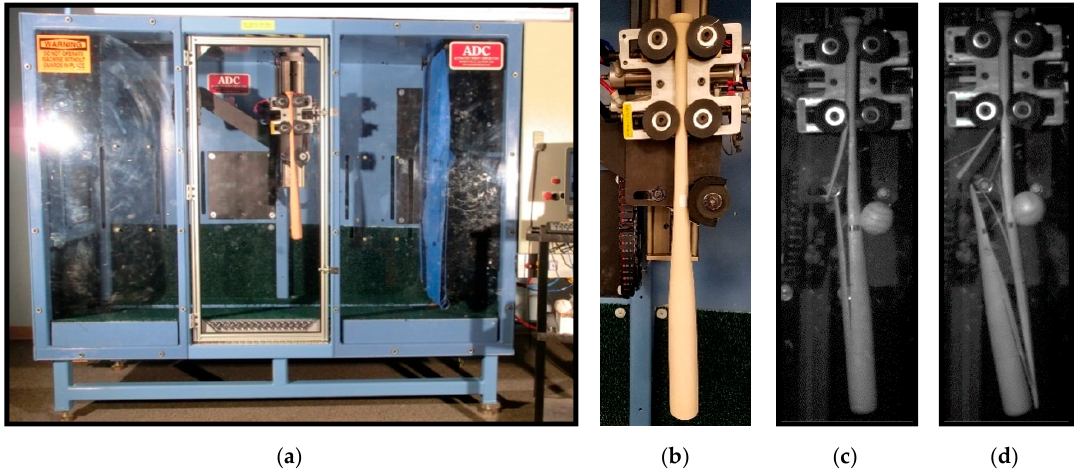
Figure 5. The testing system is shown with a wood bat hanging in machine and ready for impact: ( a ) the Bat Durability System, ( b ) Close-up view of bat in Bat Durability System, and examples of ( c ) SPF and ( d )